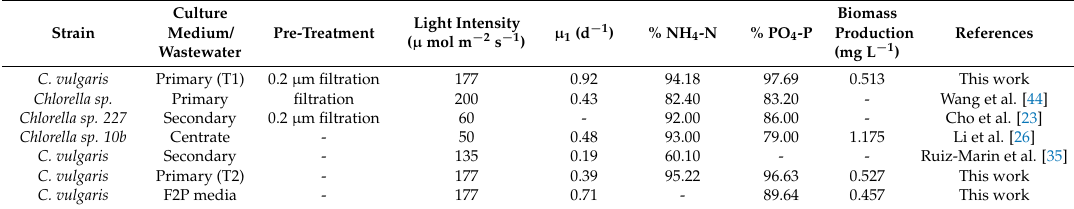
Table 4. Summary of results and comparison with previous